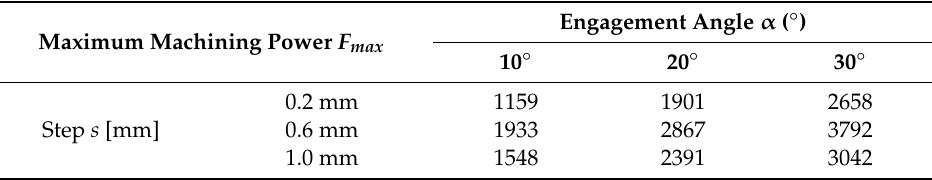
Table 7. Indirectly measured maximum machining force F max by the vector sum of experimentally measured maximum force